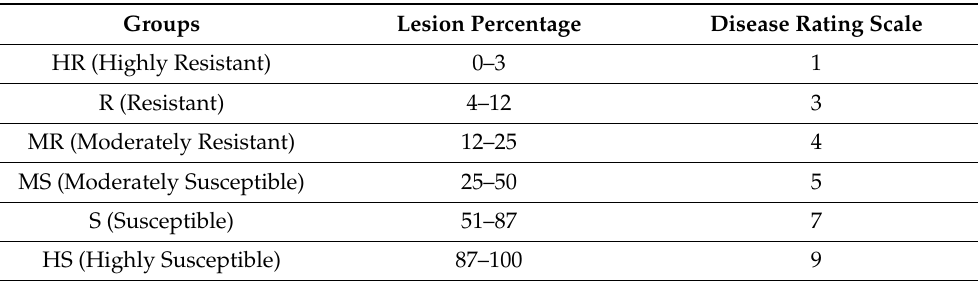
Table 4. Bacterial blight disease rating scale.